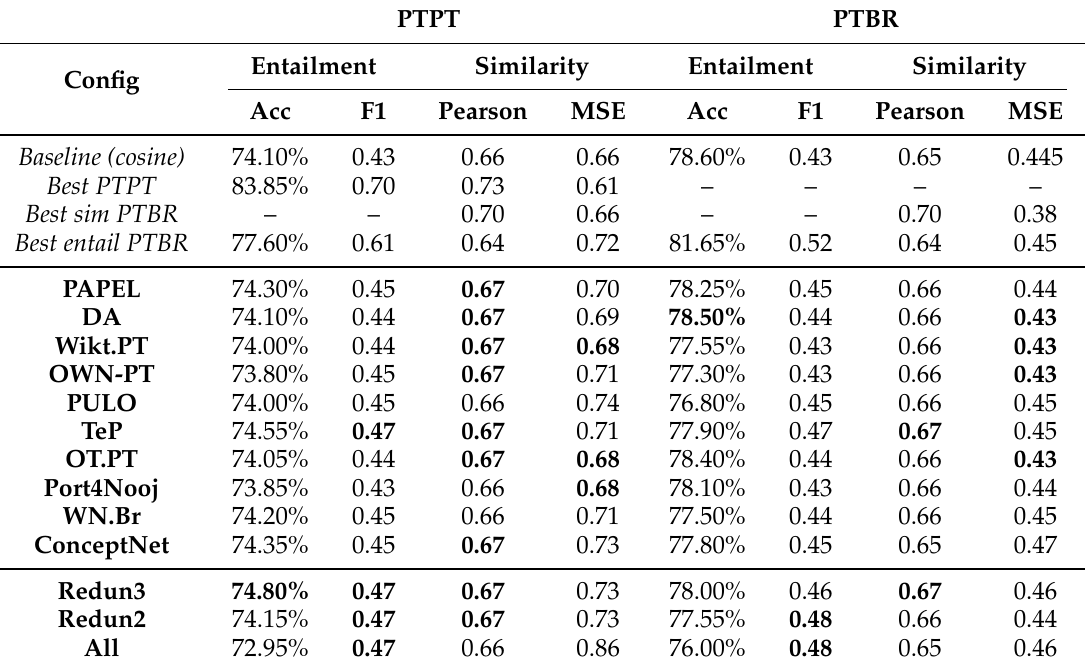
Table 17. Exploiting LKBs in the ASSIN test